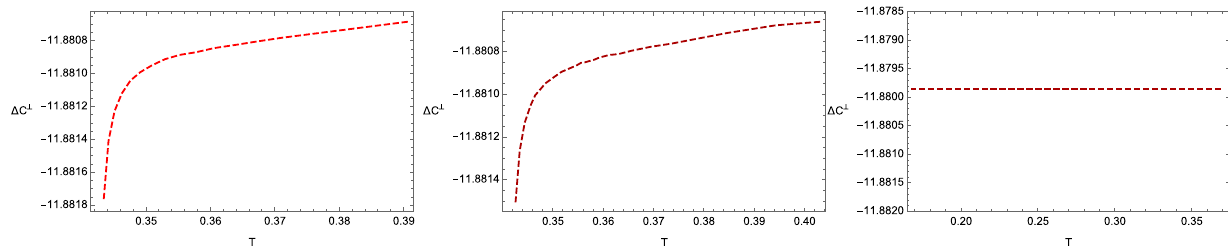
Fig. 10 In all three panels l = 0 . 5 and in the isotropic case ν = 1 and in the anisotropic case ν = 1 . 01. (cid:6) C ⊥ in terms of T at μ = 0 for the stable branch, that is large black holes ones (left). (cid:6) C ⊥ as a function of T at μ = 0 . 05 for the stable branches i.e. large black holes (middle) and small black holes ones (right)